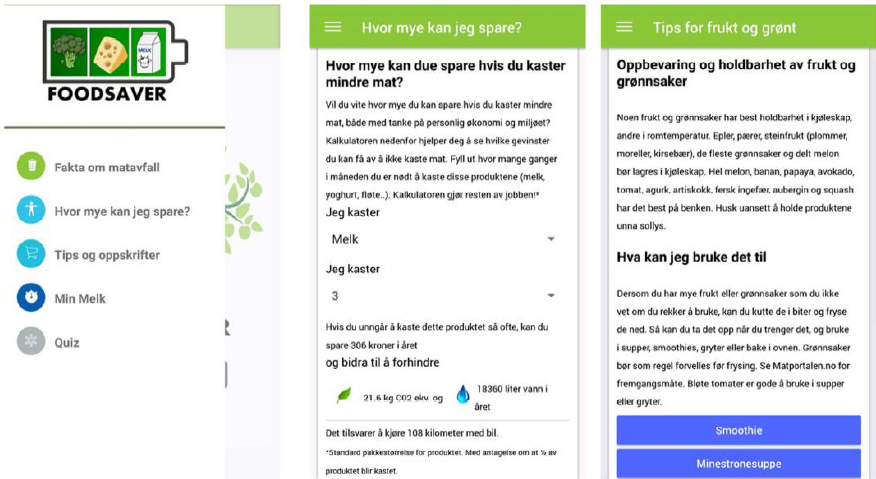
Figure A2. Screenshot of the App used in the Intervention.